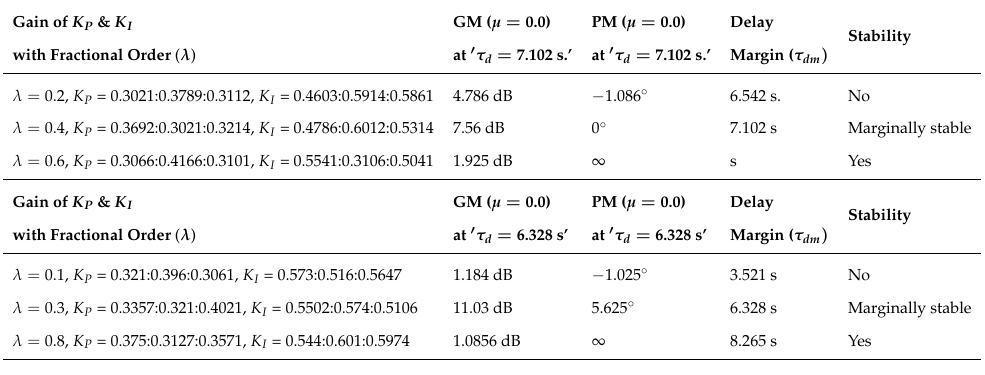
Table 7. Stability analysis for 0.3 ≤ K P ≤ 0.4 & 0.4 ≤ K I ≤ 0.6 using gain margin (GM) and phase margin (PM) from Bode plots for specified time delay ( τ d ).